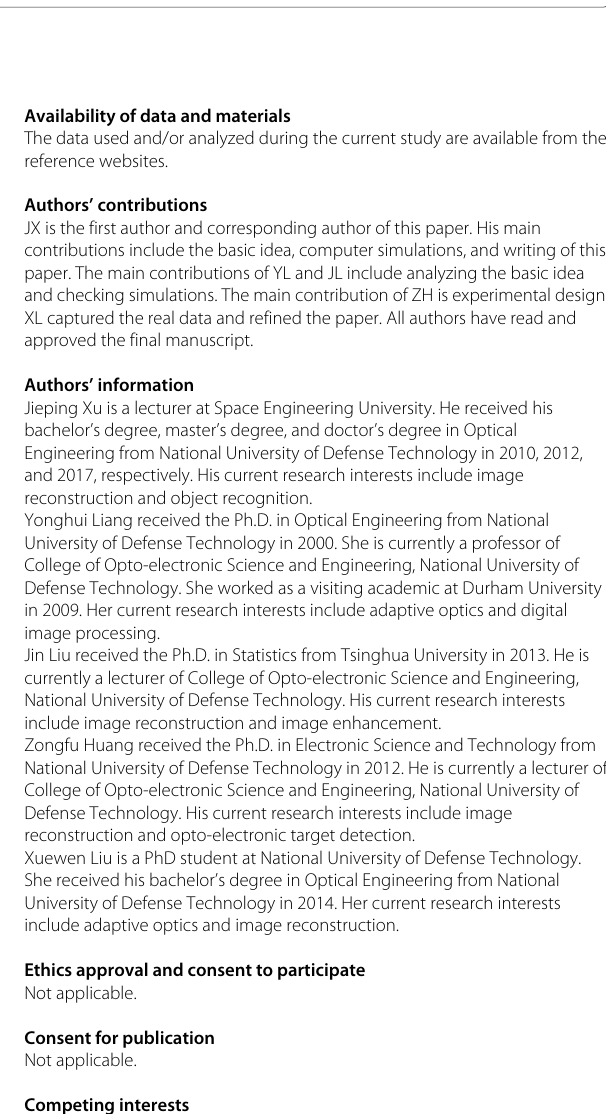
Fig. 9 Super-resolution of Gaofen-4 images. a One bicubic-interpolated LR image with an up-sampling factor equal to 2. b Reconstructed HR image by OSR with an up-sampling factor equal to 2. c Image chipped cropped from Google Earth